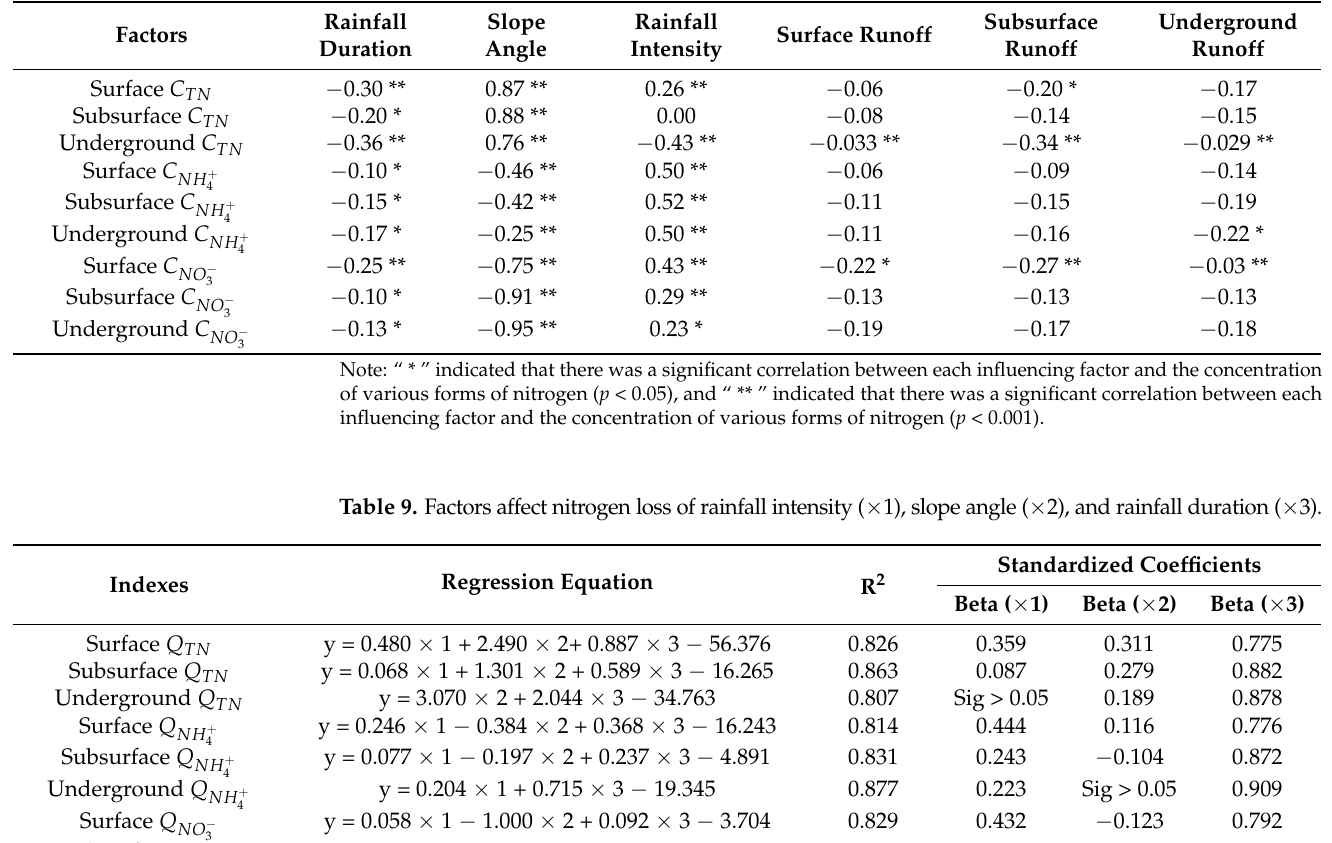
Table 8. Correlation analysis of slope and rainfall intensity with soil nitrogen loss concentration.